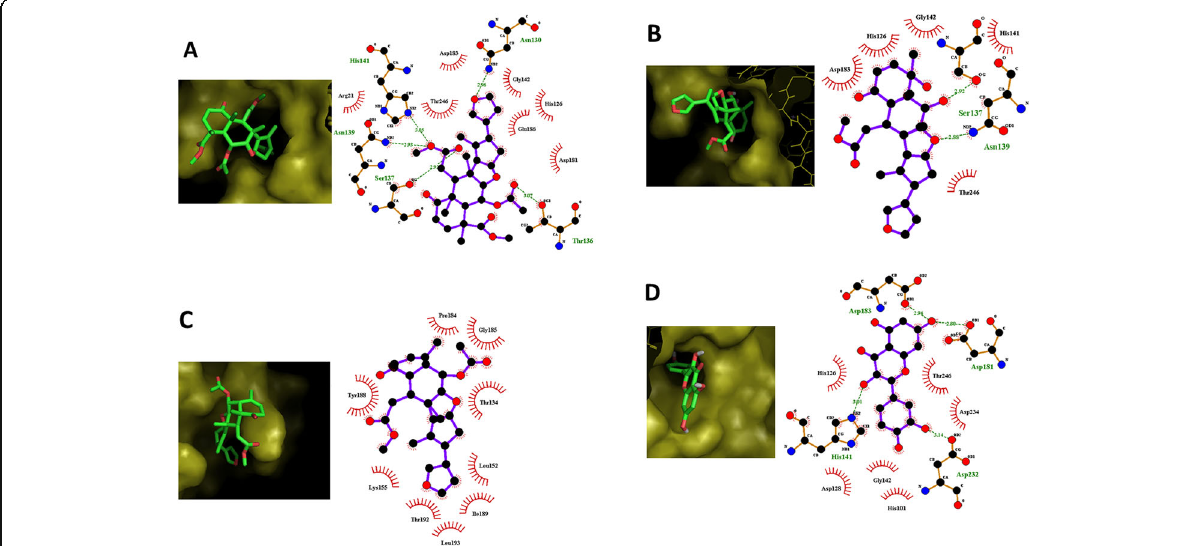
Fig. 6 The binding configuration of A . indica phytoconstituents and interaction analysis. Binding poses of a Nimbin, b Nimbandiol, c Nimbinene, and d Quercetin on Arginase-I active site as obtained from molecular docking using AutoDock Vina. Result of 2D interaction analysis shows hydrogen bond (green dashed lines) and hydrophobic interaction (red curved lines) using